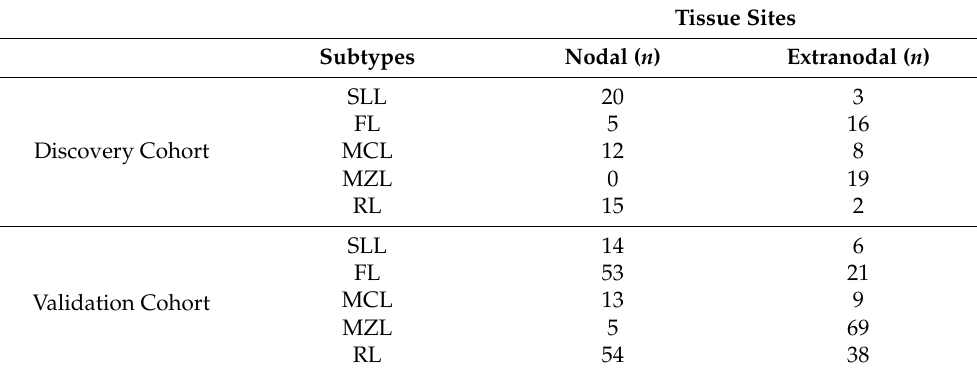
Table 1. Tissue sites of recruited samples in discovery and validation